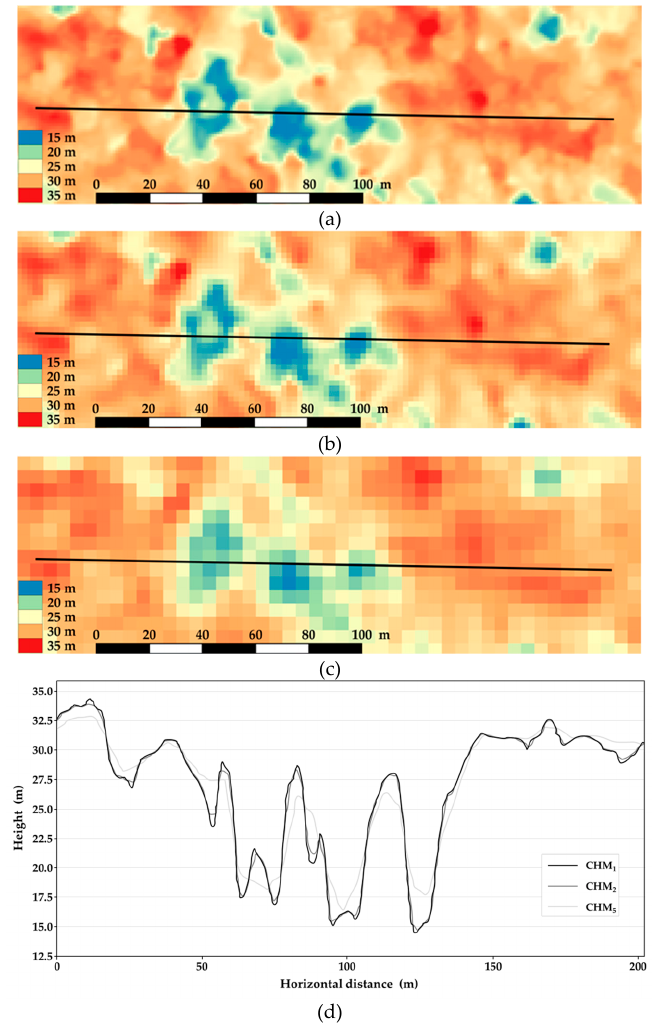
Figure 2. Examples of CHMs generated at the different spatial resolution: ( a ) CHM 1 (1 m); ( b ) CHM 2 (2 m); and ( c ) CHM 5 (5 m); and ( d ) the profile across a segment of the research area for each CHM.